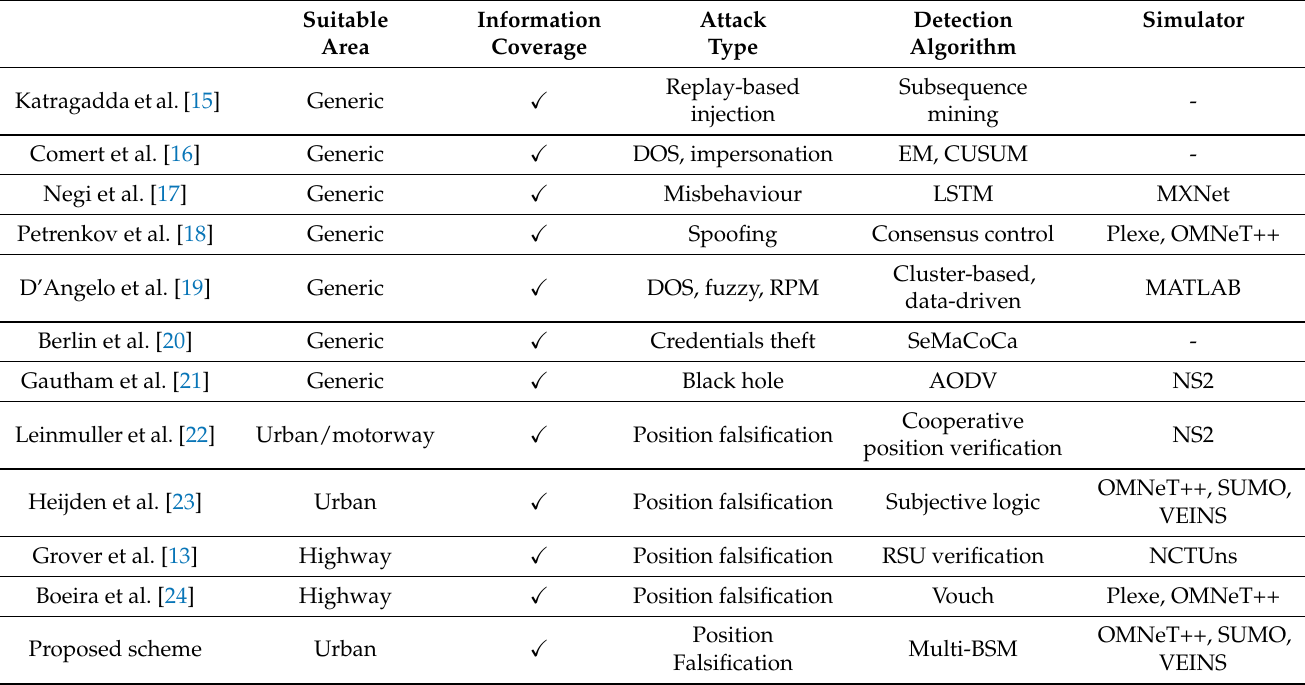
Table 1. Comparison of different attacks and proposed algorithms in connected